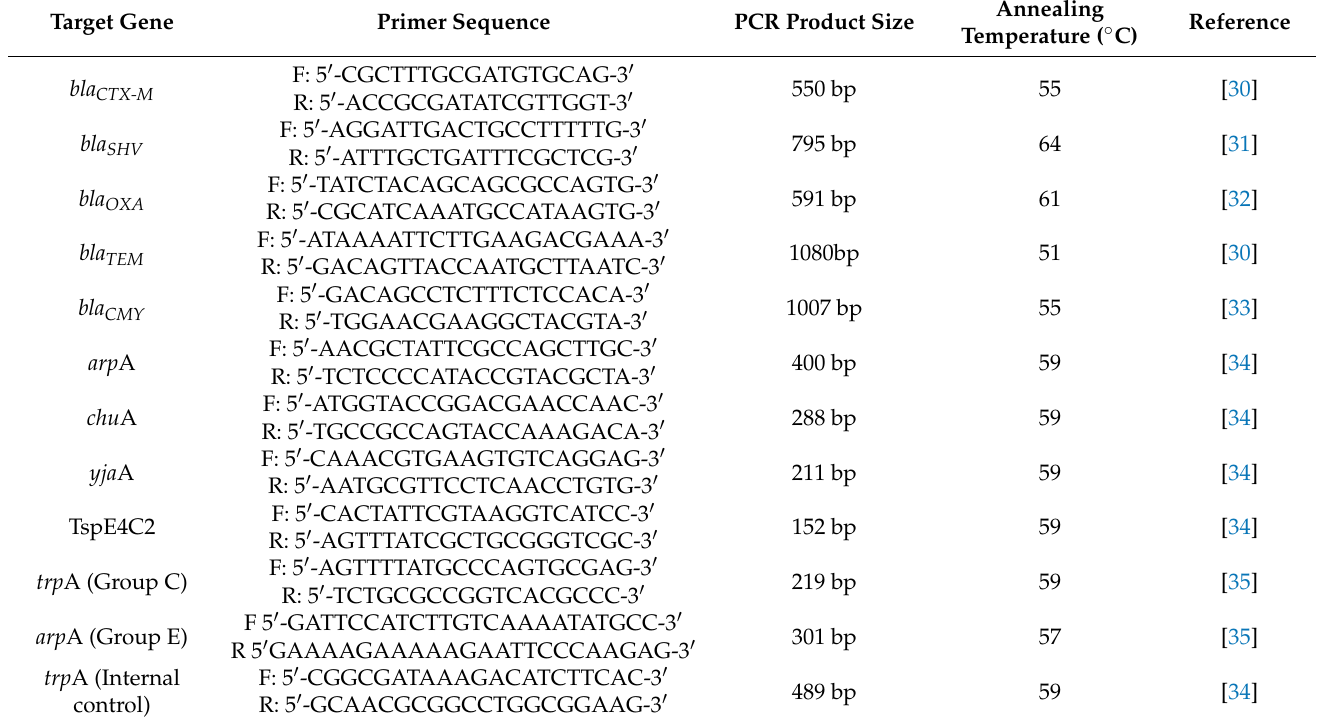
Table 1. Primers used for PCR amplification and DNA